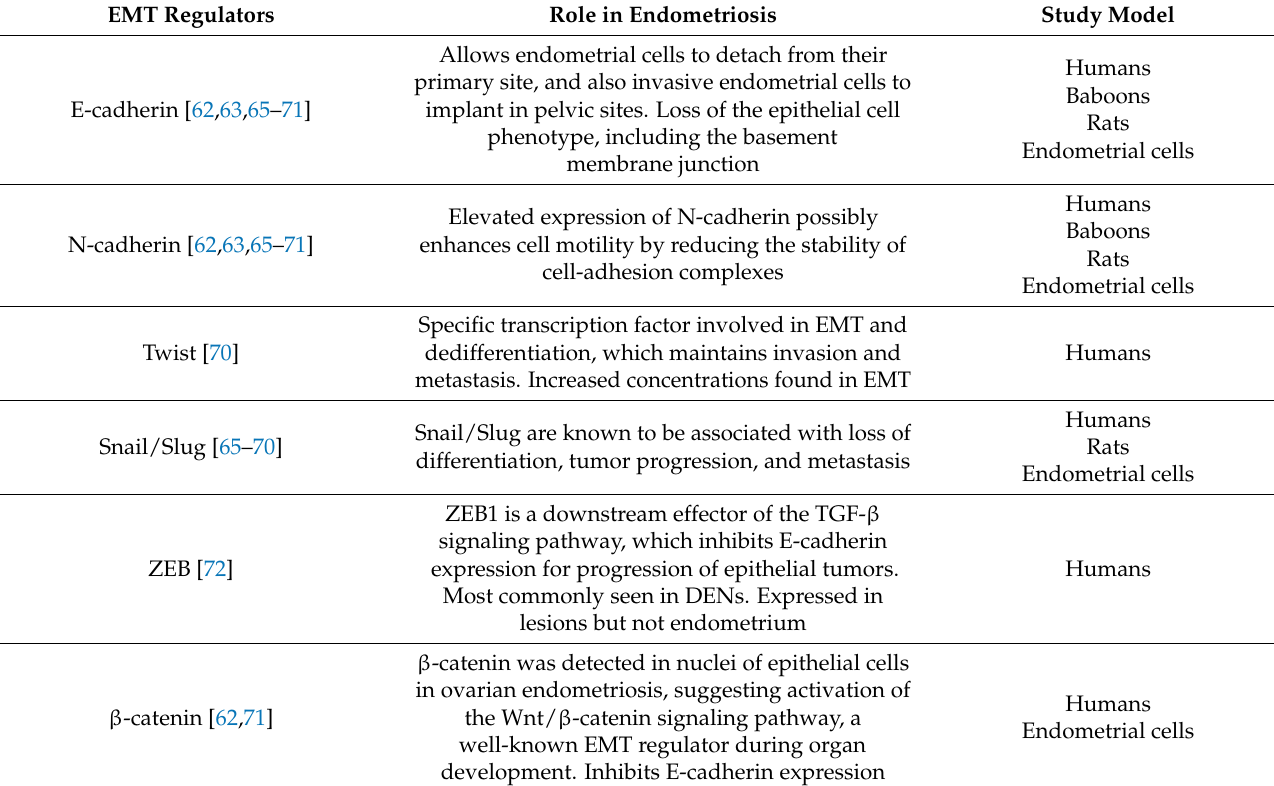
Table 6. Role of EMT regulators in the development of